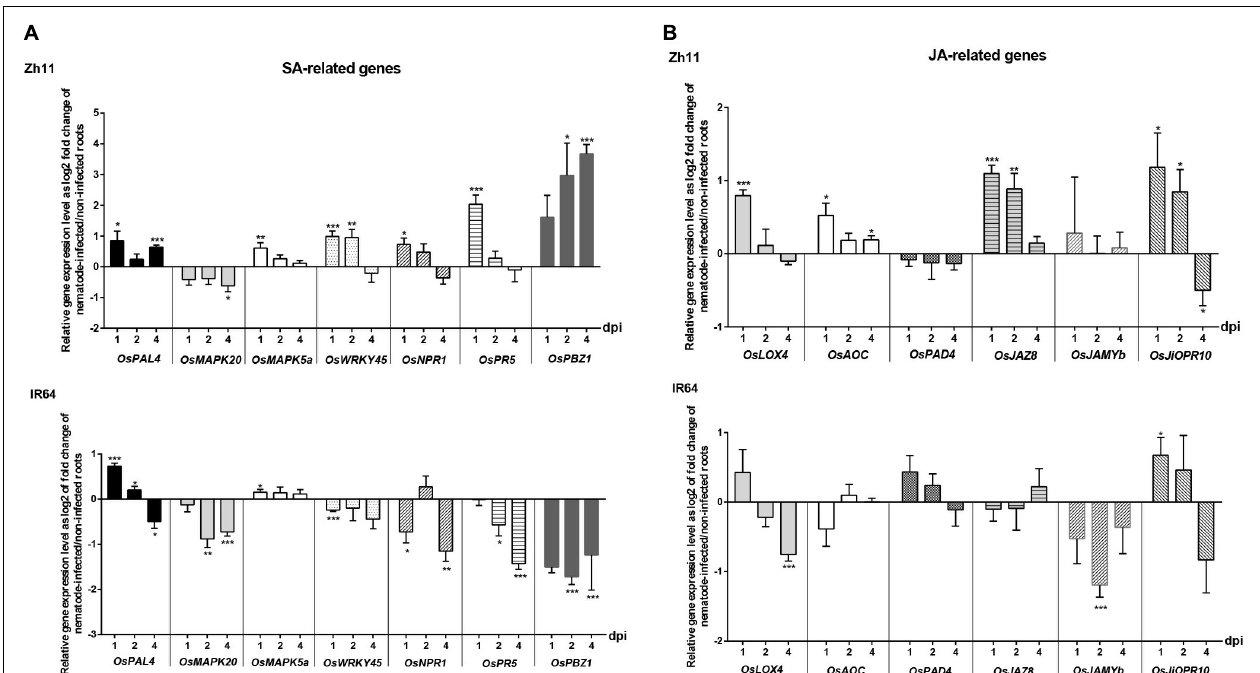
FIGURE 5 | Temporal expression pattern of genes involved in the salicylic acid (SA) and jasmonate (JA) hormonal pathways during the incompatible interaction in Zh11 and compatible interaction in IR64 with Meloidogyne graminicola . (A) Expression level of genes involved in the hormone synthesis, signalling, or response to SA. (B) Expression level of genes involved in the hormone synthesis, signalling, or response to JA. In each panel the gene expression patterns are presented in parallel for Zh11 and IR64. Ten root tips per sample were collected and pooled for inoculated and non-inoculated plants at 1, 2, and 4 days post nematode infection (dpi). Gene expression levels were measured by qRT-PCR in technical triplicates, for three independent biological repeats for each combination (genotype/treatment/time point) and normalised using the internal reference gene OseEF-1A (Os03g0177400). Bars represent at each time point the relative gene expression as log2 fold changes of the mean and standard error for nematode-inoculated root sample compared with uninfected control plants grown under the same conditions. The result of the Student’s t -test comparing for each time point the gene expression in root inoculated vs. non-inoculated conditions is indicated on top of the bar when there is a significant difference of the means with p value < 0.05 (*), p ≤ 0.01 (**), or p ≤ 0.001 (***). Genes investigated: the phenylalanine ammonia-lyase OsPAL4 (Os02g0627100); the phytoalexin deficient OsPAD4 (Os11g0195500); the mitogen-activated protein kinases OsMAPK20 (Os01g0629900) and OsMAPK5a (Os03g0285800); the WRKY transcription factor OsWRKY45 (Os05g0322900); the non-expressor of pathogenesis-related genes OsNPR1 (Os01g0194300); the pathogenesis-related OsPR5 (Os12g0628600) and OsPR10a/PBZ1 (Os12g0555500); the lipoxygenase OsLOX4 (Os03g0700400); the allene oxide cyclase OsAOC (Os03g0438100); the jasmonate-ZIM-domain 8 OsJAZ8 (Os09g0439200); the R2R3 MYB OsJAMYb (Os11g0684000); the jasmonic acid inducible pathogenesis-related class 10 OsJiOPR10